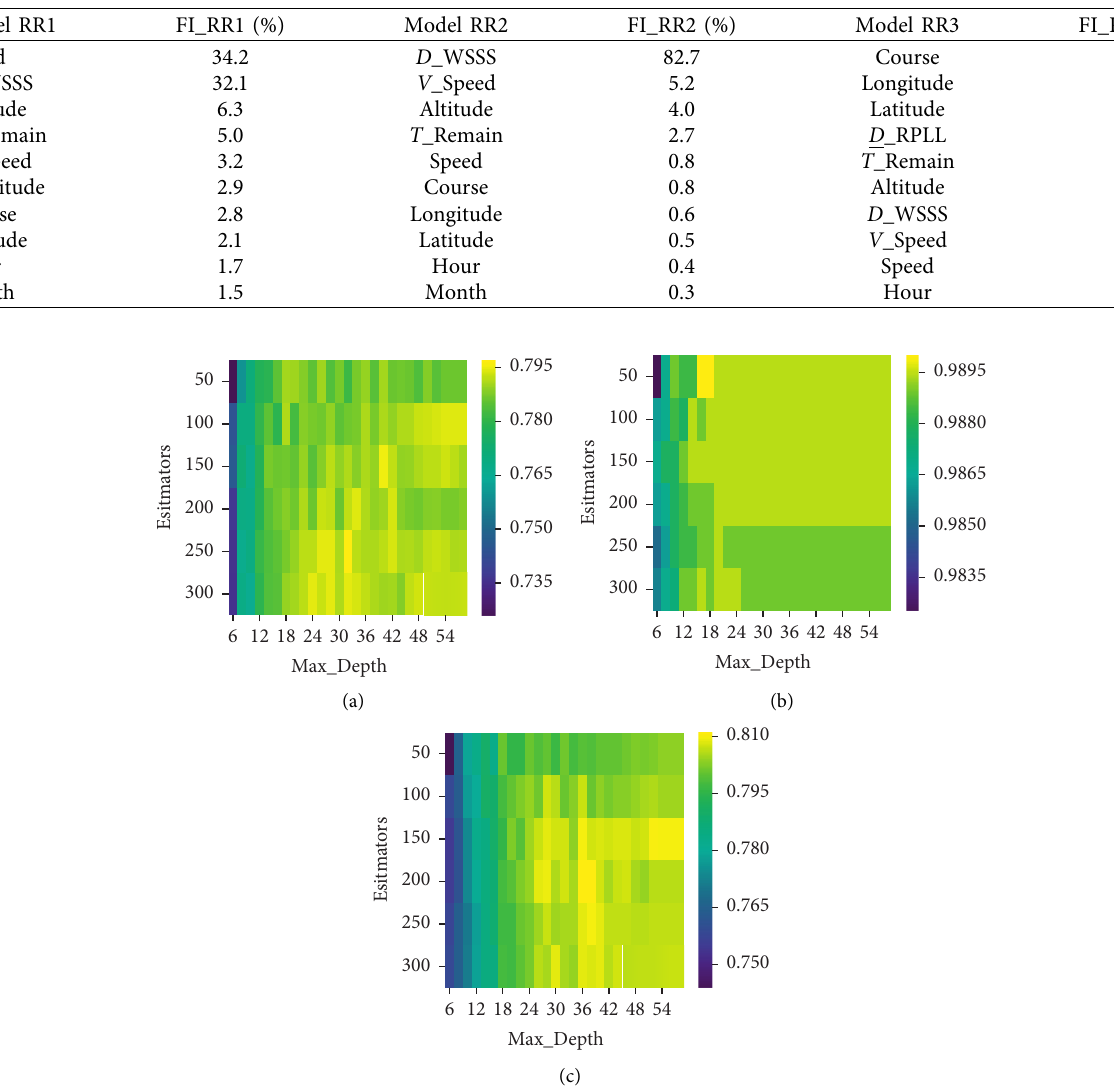
Figure 15: Example for flight direction. Black dots are entry points and red dots are exit points. Table 6: Feature importance of random forest models for action value prediction.